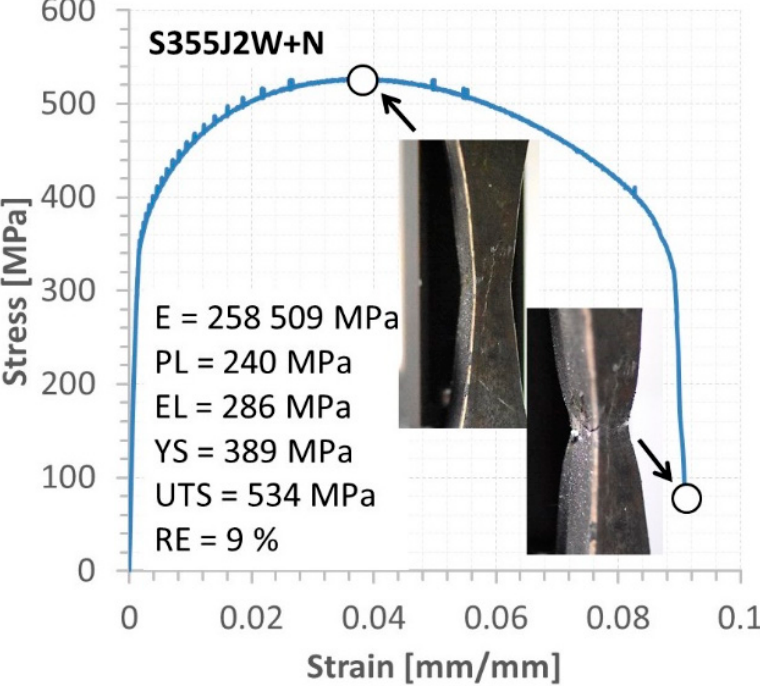
Figure 13. Tensile characteristics and mechanical parameters of S355J2W+N steel.